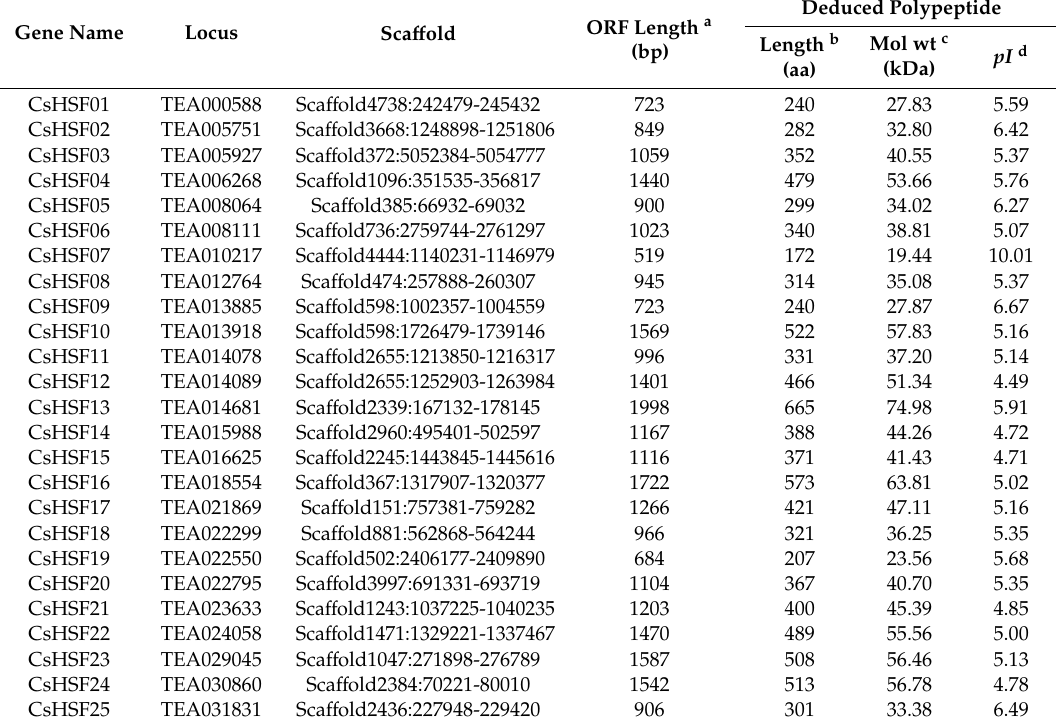
Table 1. Key features of heat transcription factors (HSFs) in Camellia sinensis